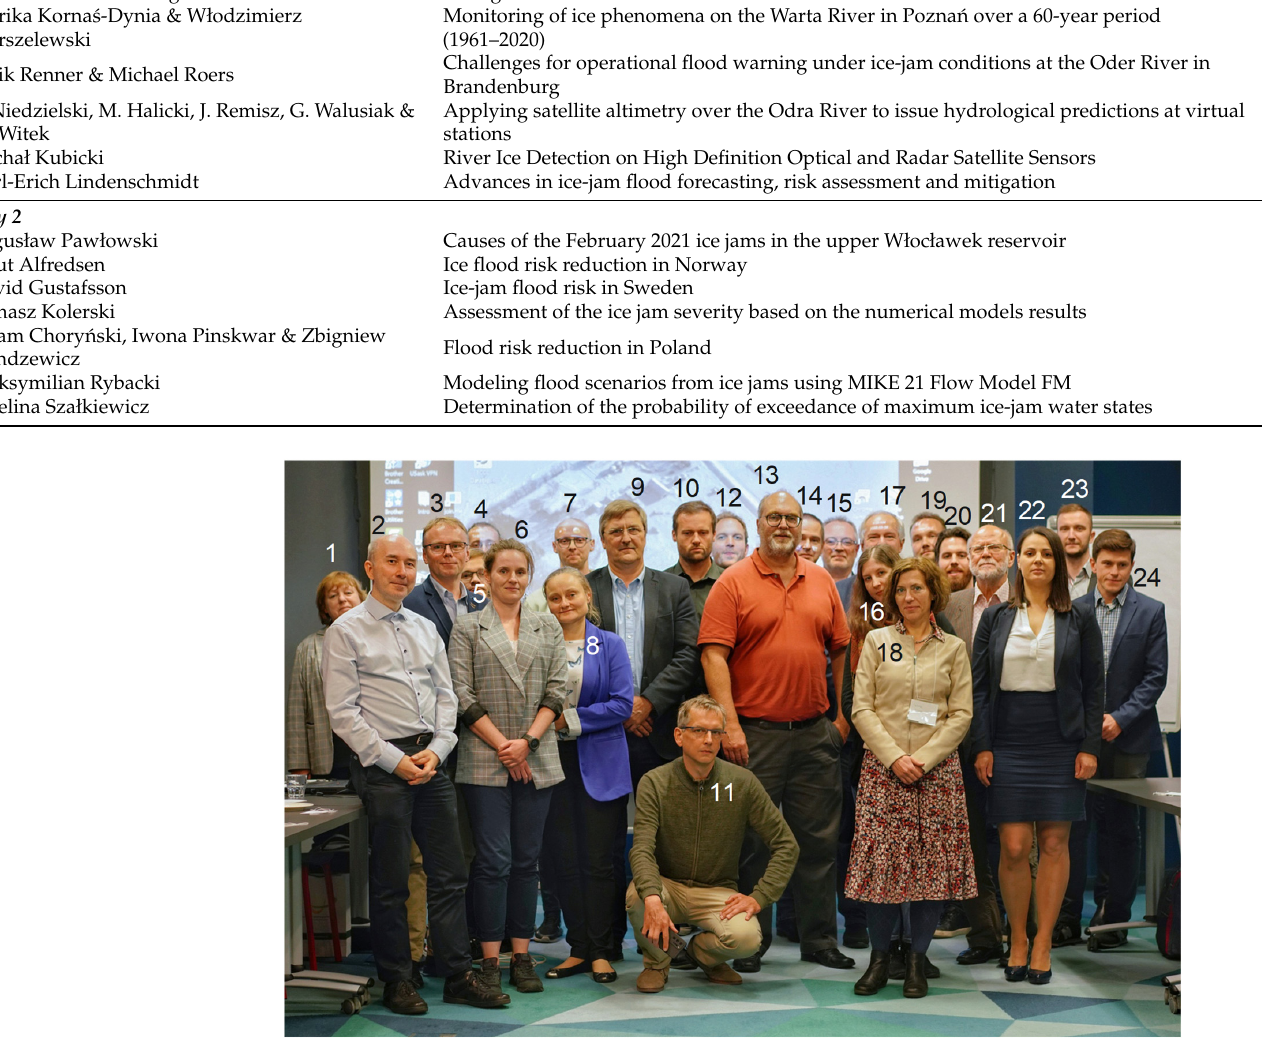
Figure 1. Most of the participants of the workshop: 1. Cornelia Lauschke, 2. Maciej Zdralewicz, 3. Tomasz Kolerski, 4. Grzegorz Walusiak, 5. Maik Renner, 6. Joanna Remisz, 7. Michal Halicki, 8.